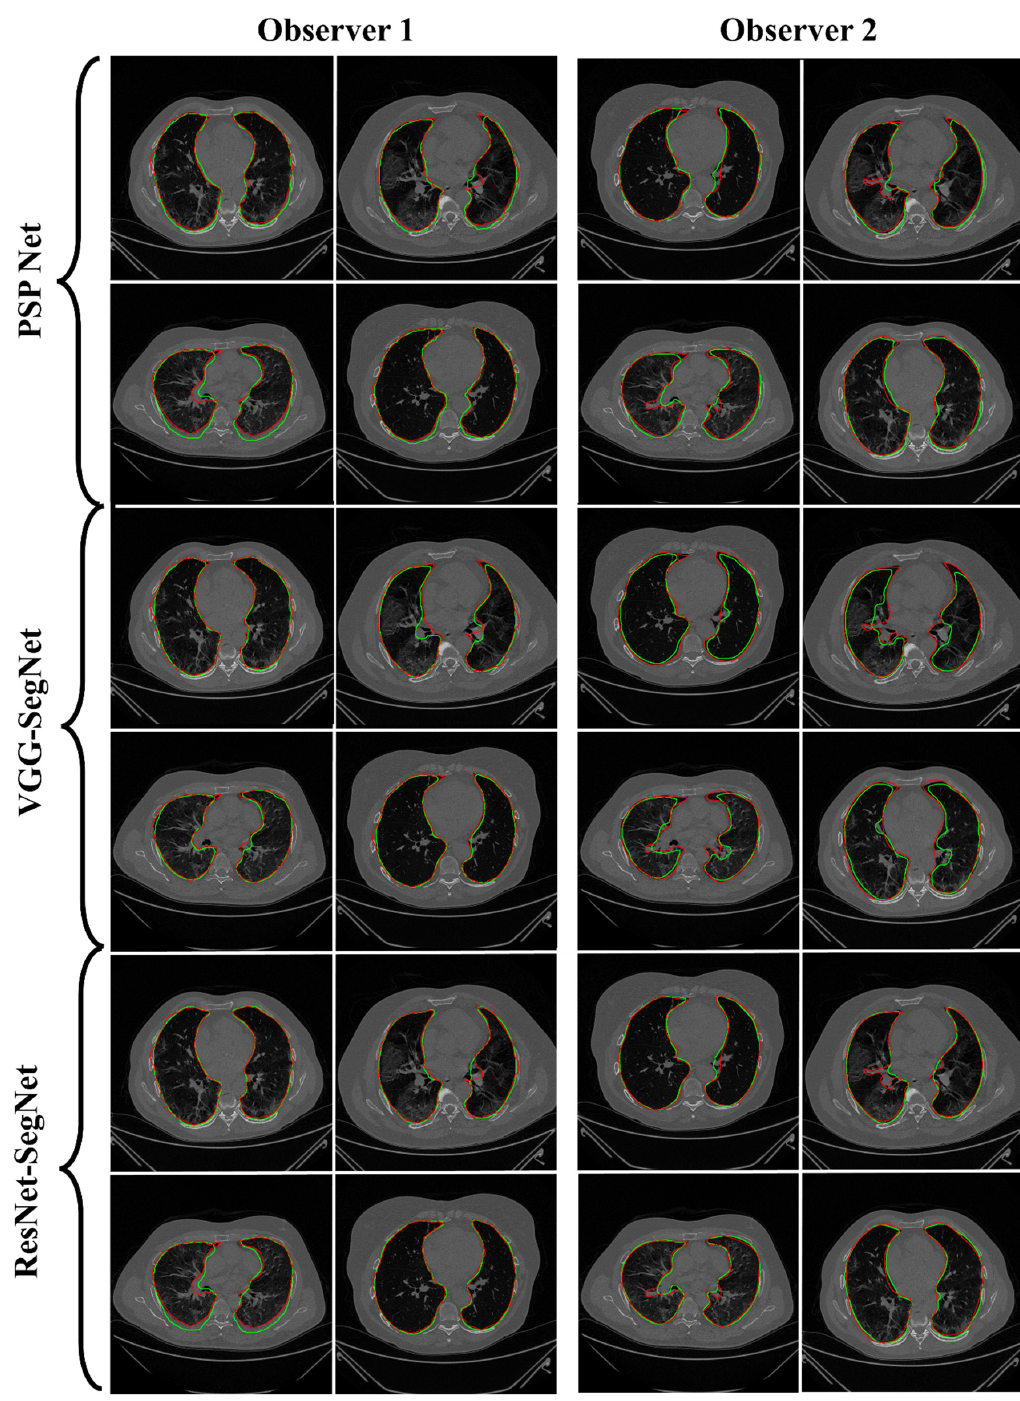
Figure 10. AI-model segmented boundary (green) vs. GT boundary (red) for Observer 1 and Observer 2.